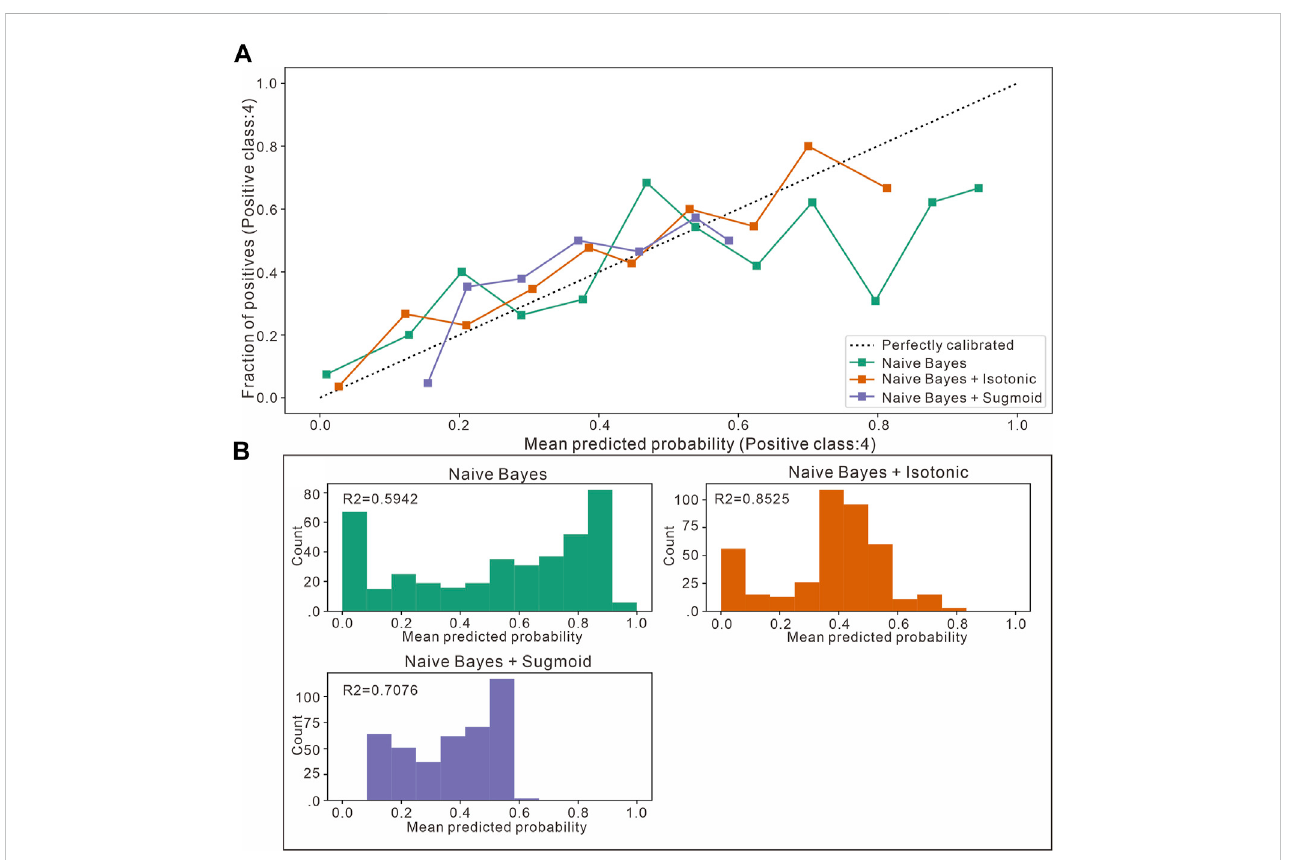
FIGURE 10 Comparison between Naive Bayesian identi fi cation and two probabilistic calibration curves for the second section of the Sangonghe Formation in the Moxizhuang area (taking fi ne sandstone as an example). (A) Calibration plots (reliability curve). It plots the true frequency of the positive label against its predicted probability, for binned predictions. (B) The histogram gives some insight into the behavior of each classi fi er by showing the number of samples in each predicted probability bin.